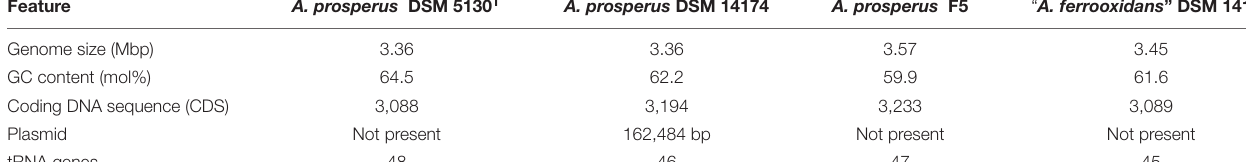
TABLE 1 | Comparison of the genomic features of the four members of the Acidihalobacter genus. Feature